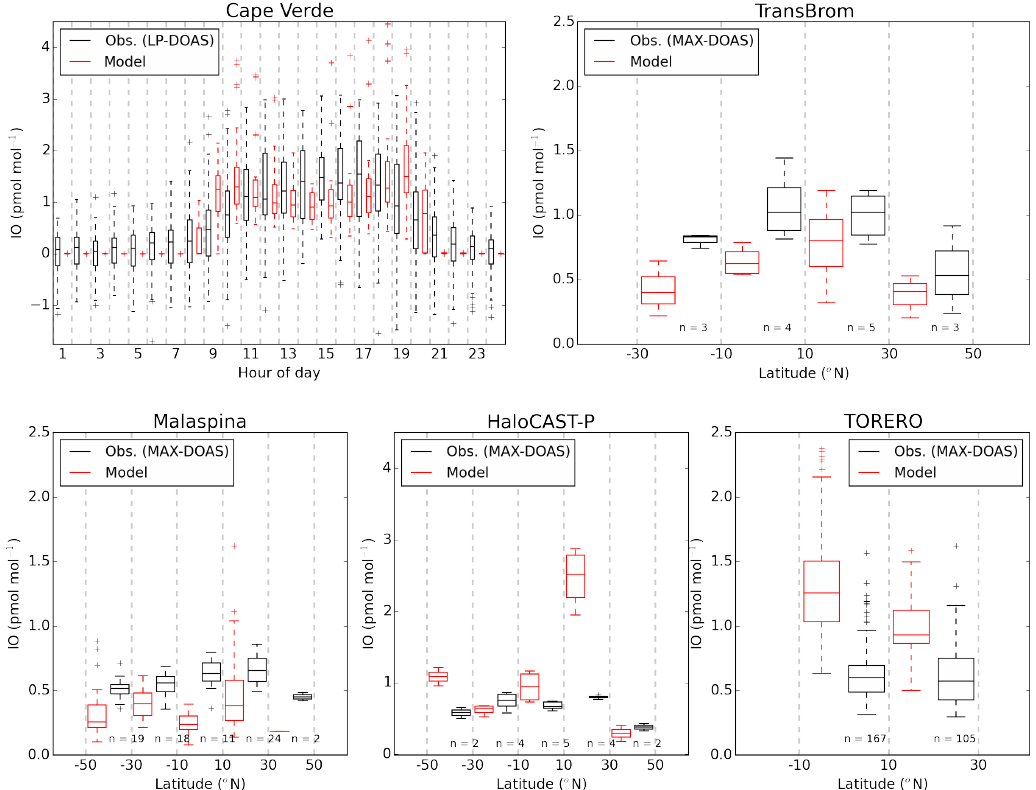
Figure 7. Iodine oxide (IO) surface observations (black) by campaign compared against the simulation with halogen chemistry (“Cl + Br + I”, red). Cape Verde measurements are shown against hour of day and others are shown as a function of latitude. Values are considered in 20 ◦ bins, with observations and modelled values at the same location and time (as described in Sect. 2) shown side-by-side around the midpoint of each bin. The extent of the bins is highlighted with grey dashed lines. Observations are from Cape Verde (tropical Atlantic; Mahajan et al., 2010; Read et al., 2008), TransBrom (western Pacific; Großmann et al., 2013), the Malaspina circumnavigation (Prados-Roman et al., 2015b), HaloCAST-P (eastern Pacific; Mahajan et al., 2012), and TORERO ship (eastern Pacific; Volkamer et al., 2015). The number of data points within latitudinal bin is shown as “n”. The box plot extents give the interquartile range, with the median shown within the box. The whiskers give the most extreme point within 1.5 times the interquartile range. Locations of observations are shown in Fig.